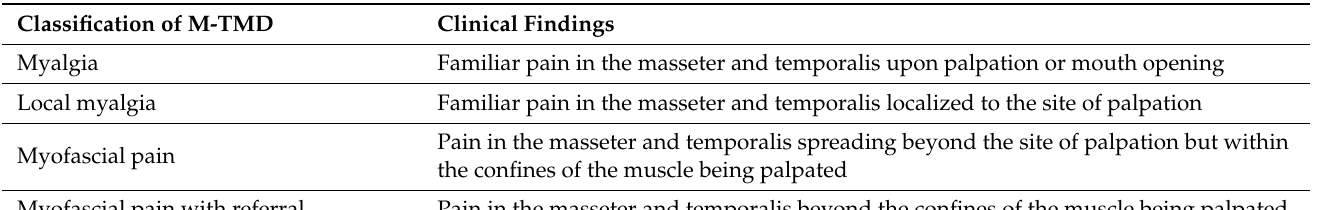
Table 1. Classification of myogenous temporomandibular disorders (M-TMD) according to the Diagnostic Criteria for Temporomandibular Disorders